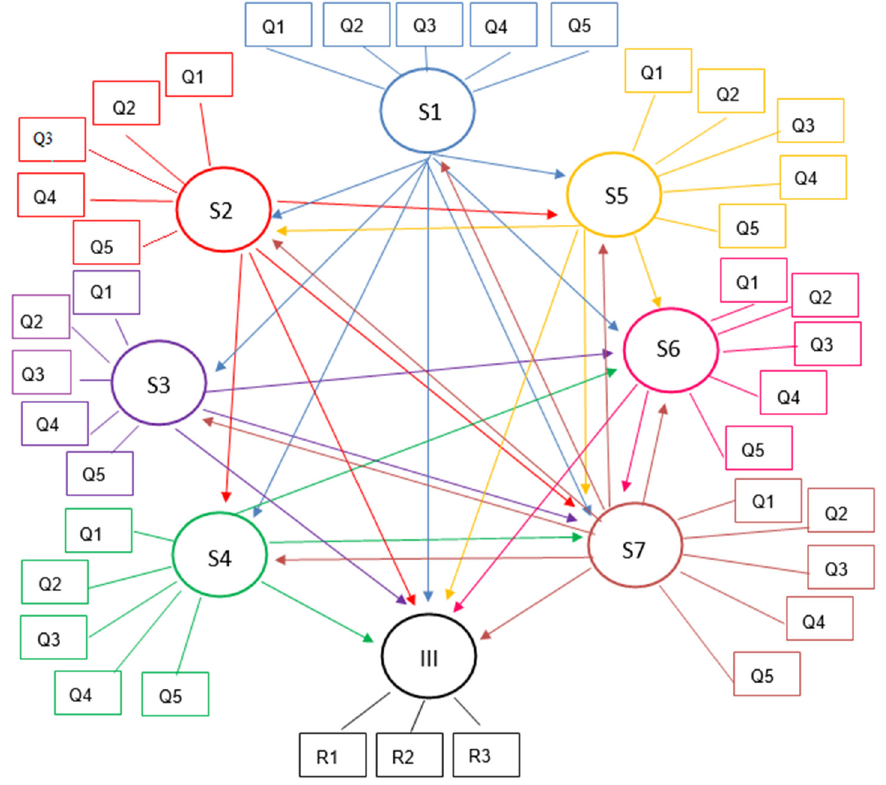
Figure 3. Links between the analyzed criteria.